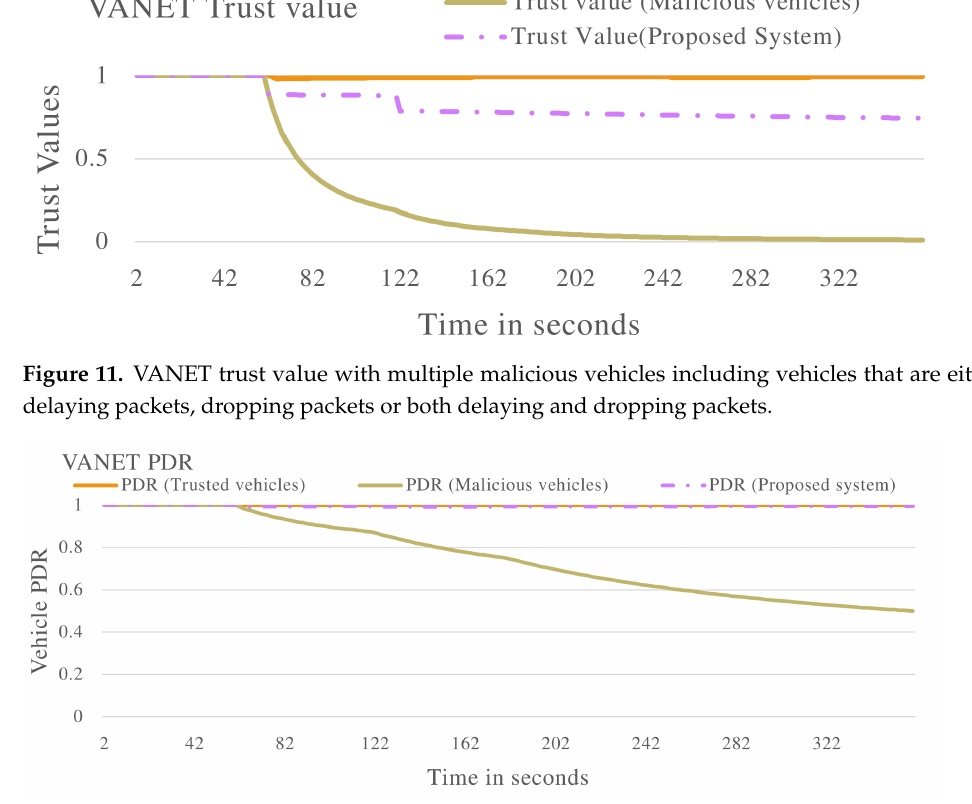
Figure 12. VANET packet delivery ratio with multiple malicious vehicles including vehicles that are either delaying packets, dropping packets or both delaying and dropping packets.